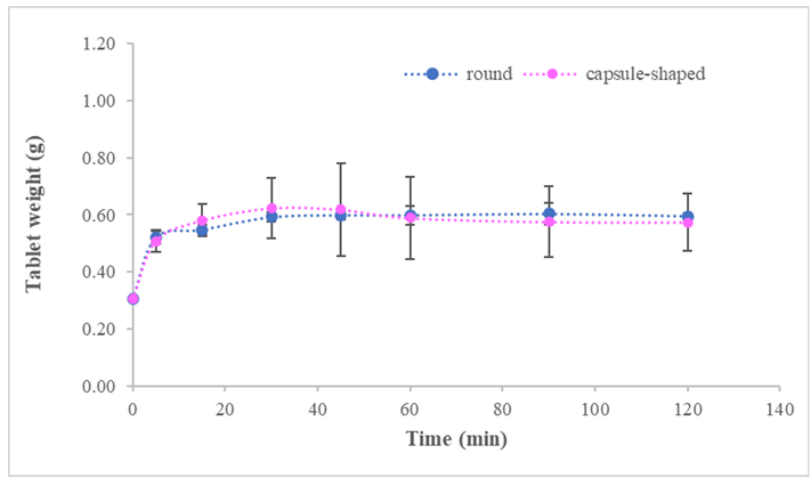
Figure 8. Mean swelling profile obtained for capsule-shaped and round bidirectional tablets. n = 3.